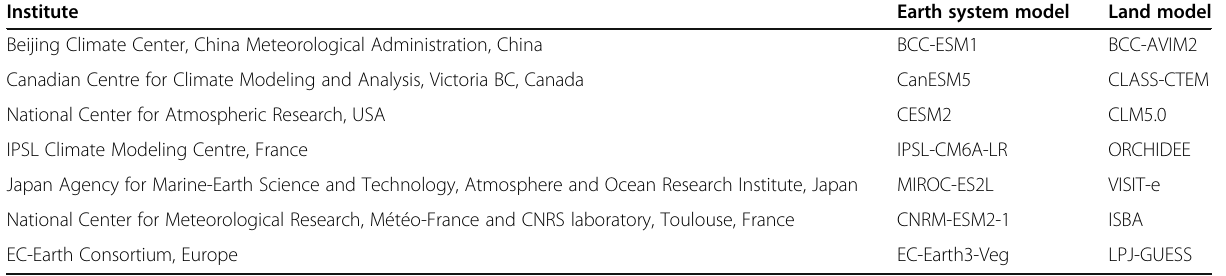
Table 1 The list of seven Earth system models used in this study from